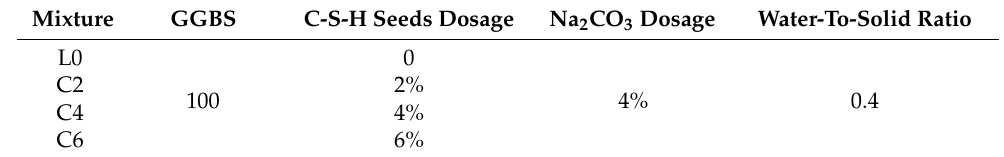
Table 1. Deigned mixtures with different dosages of C-S-H